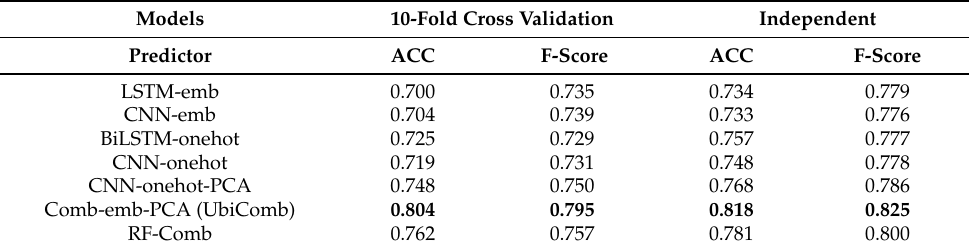
Table 2. Results of different techniques.